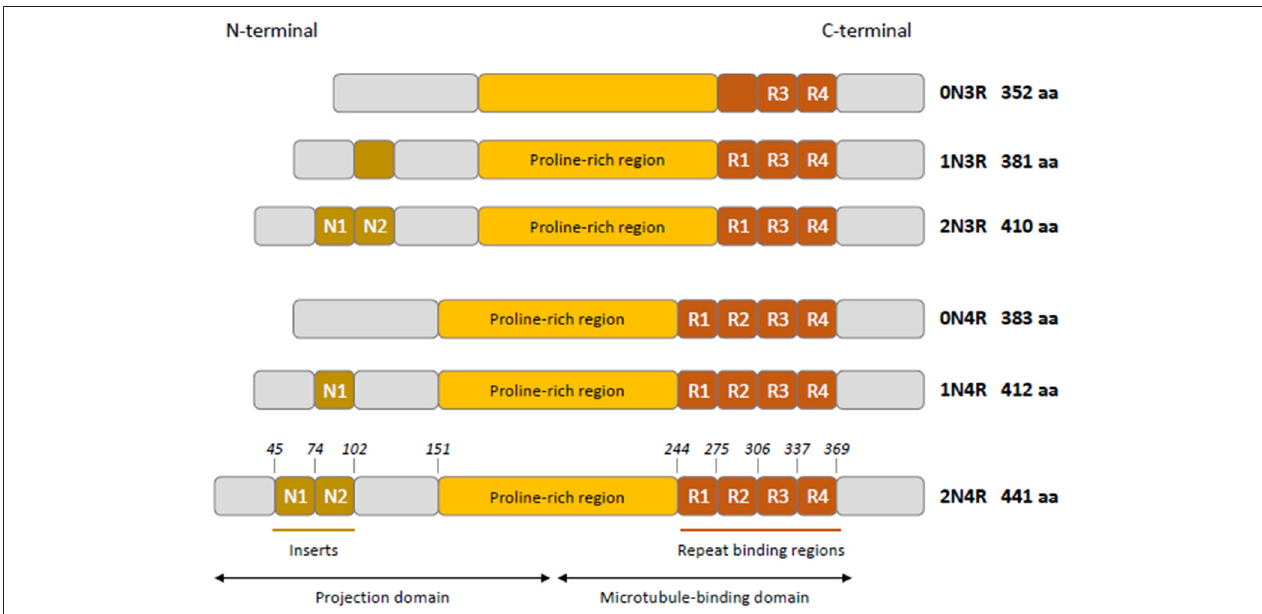
FIGURE 1 | Schematic representation of tau isoforms in human adult brain. Tau isoforms (0N3R, 1N3R, 2N3R, 0N4R, 1N4R, 2N4R) are generated by alternative splicing of exons 2, 3, and 10. Two inserts N1 and N2 (brown boxes) near the N-terminus of tau are produced by exons 2 and 3, respectively. Absence of N1 and N2 gives rise to 0N isoforms, whereas inclusion of N1 produces 1N isoforms and inclusion of both N1 and N2 results in 2N isoforms. The proline-rich region is indicated in yellow. R1–R4 (orange boxes) represent the four microtubule- binding repeats, R2 being encoded by exon 10. The exclusion or inclusion of exon 10 results in isoforms with three or four microtubule-binding repeats named 3R and 4R